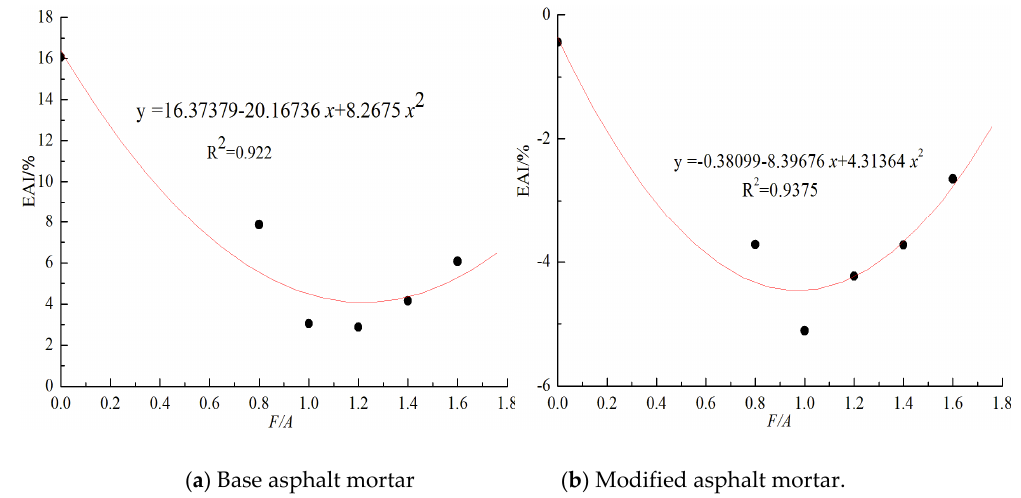
Figure 10. Activation energy index about these different types of asphalt mortar.